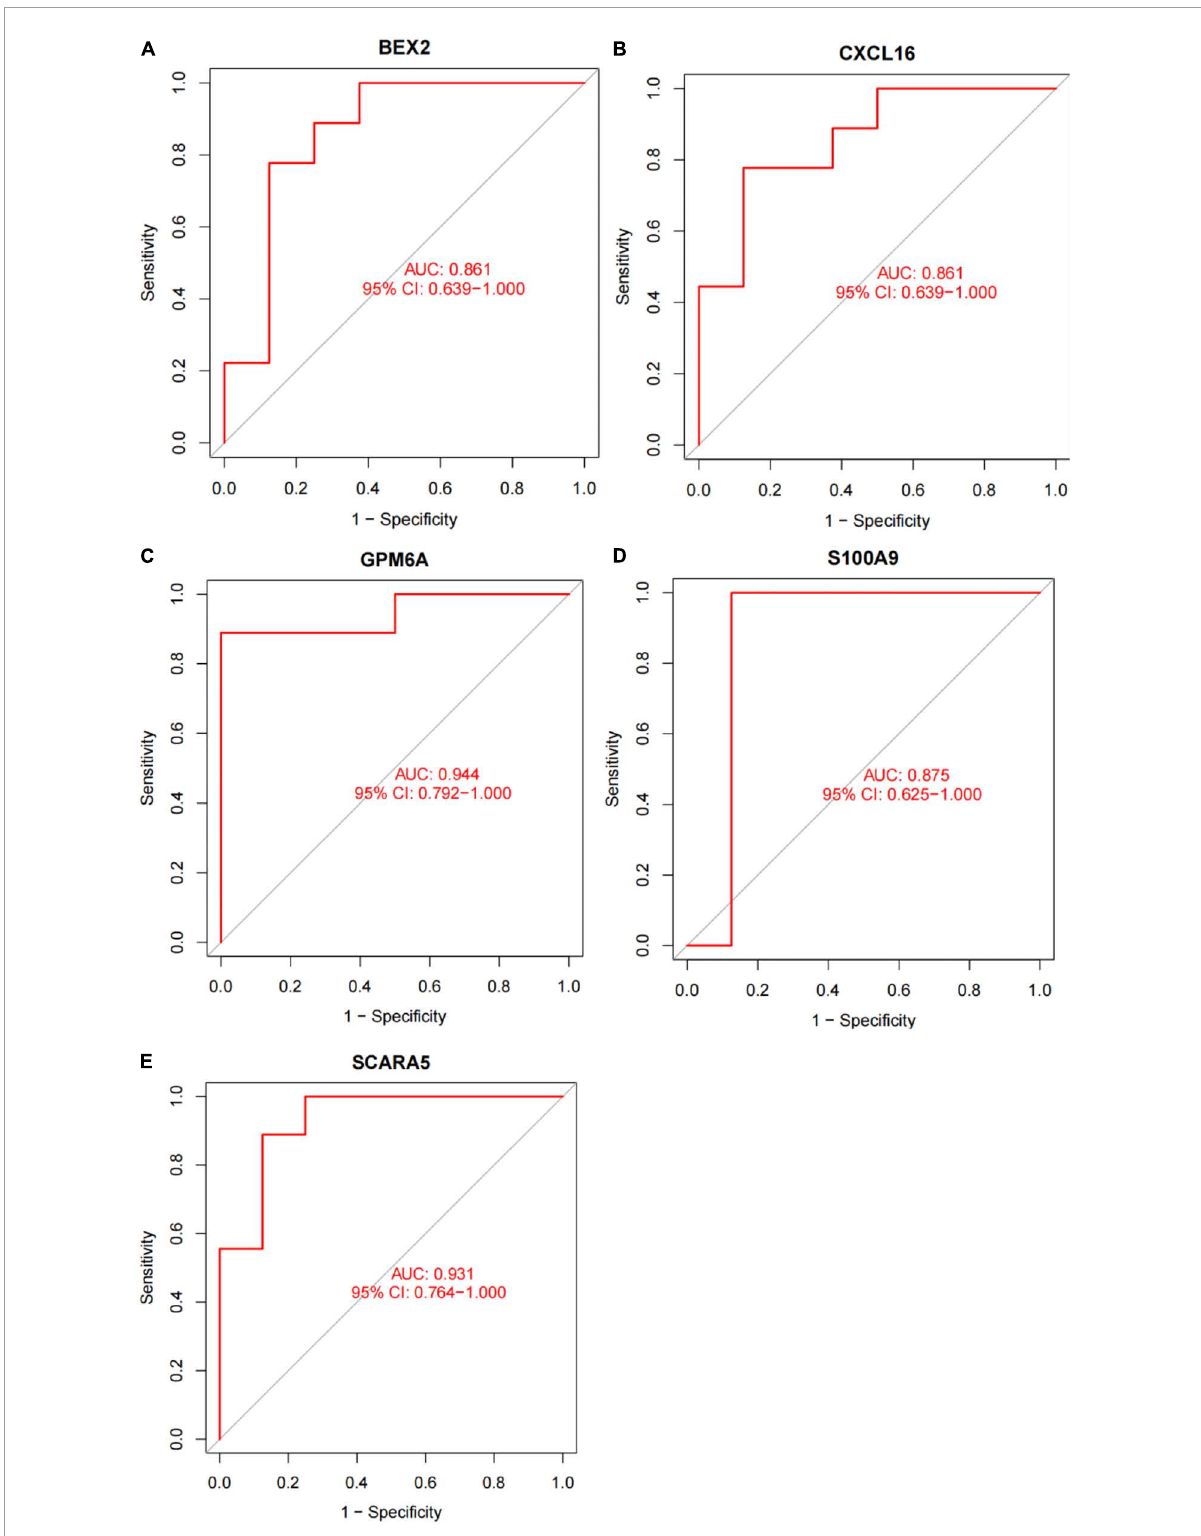
FIGURE8 The diagnostic effect of five markers in the test set. (A) The diagnostic effect of BEX2 in the test set. (B) The diagnostic effect of CXCL16 in the test set. (C) The diagnostic effect of GPM6A in the test set. (D) The diagnostic effect of S100A9 in the test set. (E) The diagnostic effect of SCARA5 in the test set. The points marked on the ROC curve are the optimal threshold points, and the values in parentheses represent sensitivity and specificity. The AUC value is the area under the ROC curve.